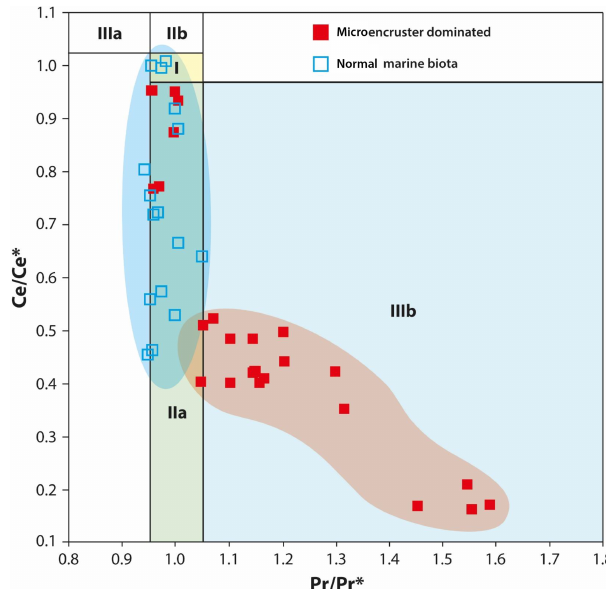
Figure 6. Lanthanum anomaly diagram (Ce anomaly, y axis vs. Pr anomaly, x axis). Field I: no anomaly; field IIa: positive La anomaly causing an apparent negative Ce anomaly; field IIb: negative La anomaly causing an apparent positive Ce anomaly; field IIIa: gen- uine positive Ce anomaly; field IIIb: genuine negative Ce anomaly. All data points plot in field IIIb, indicating a genuine negative Ce anomaly, whereas values plotting in field IIa indicate slightly over- estimated Ce anomaly values due to a positive La anomaly (after Bau and Dulski, 1996; Bodin et al.,